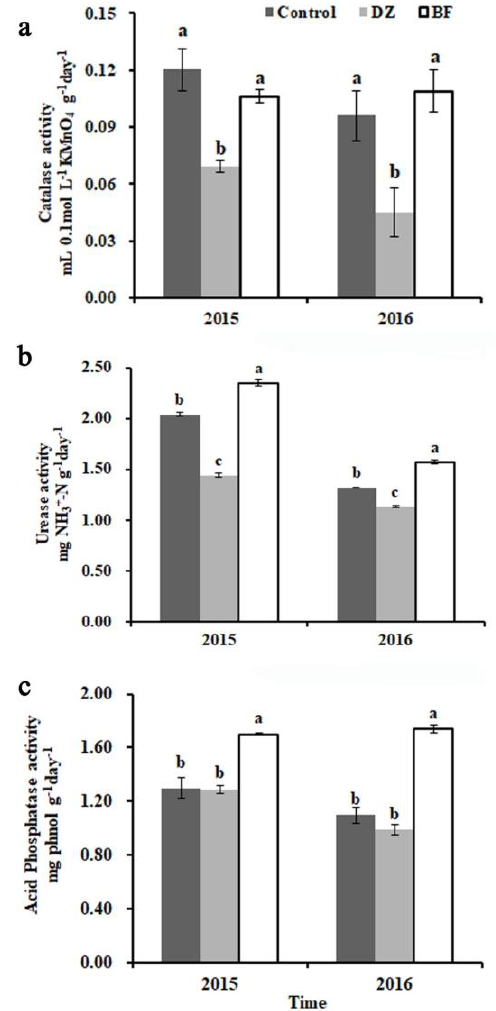
Figure 3. Enzyme activity. ( a ) Catalase; ( b ) urease; ( c ) acid phosphatase activity in rhizosphere soils of different treatment. Bars represent the mean, and whiskers represent the standard deviation.